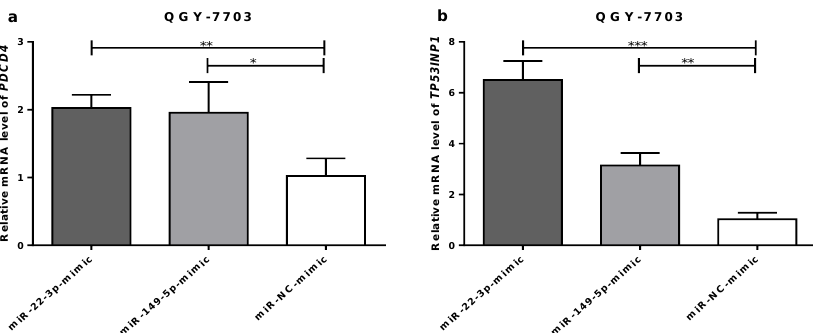
Figure 7. mRNA expression of PDCD4 and TP53INP1 in QGY-7703 after miR-22-3p mimic (100 nM), miR-149-5p mimic (100 nM), or miR-NC mimic (100 nM) transfection; GAPDH served as an internal reference. ( a ) RT-qPCR assays reveal the mRNA expression of PDCD4 in QGY-7703 cells after transfection 48 h. ( b ) RT-qPCR assays reveal the mRNA expression of TP53INP1 in QGY-7703 cells after